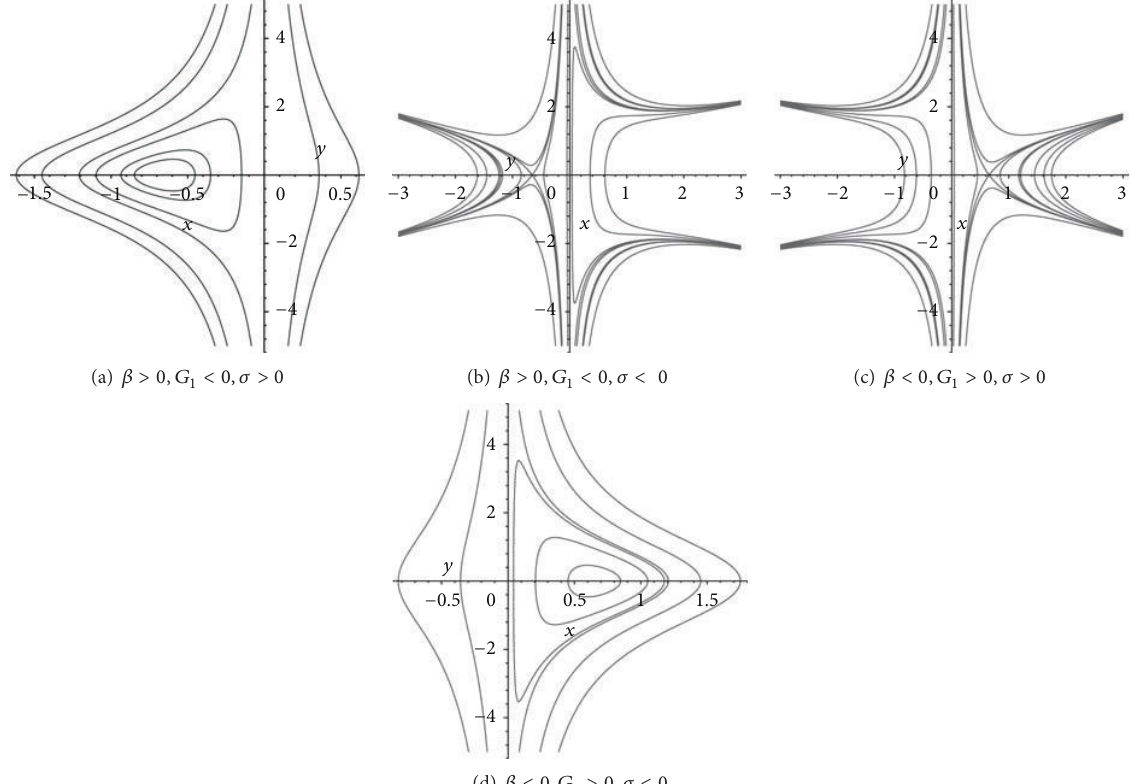
Figure 5: The phase portraits of system (6) for 𝑛 = 2𝑚 , and 𝛽𝐺 1 < 0 .